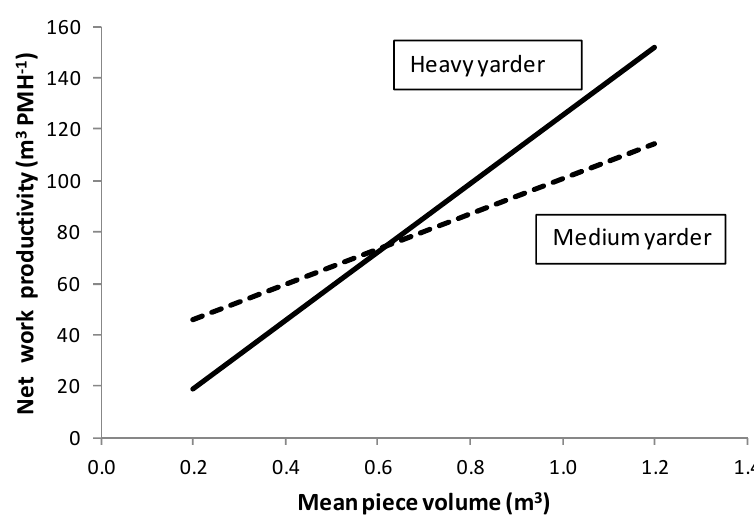
Figure 5. Net productivity of the two excavator-based grapple yarder types as a function of piece volume, estimated using the regression models in Table 5.